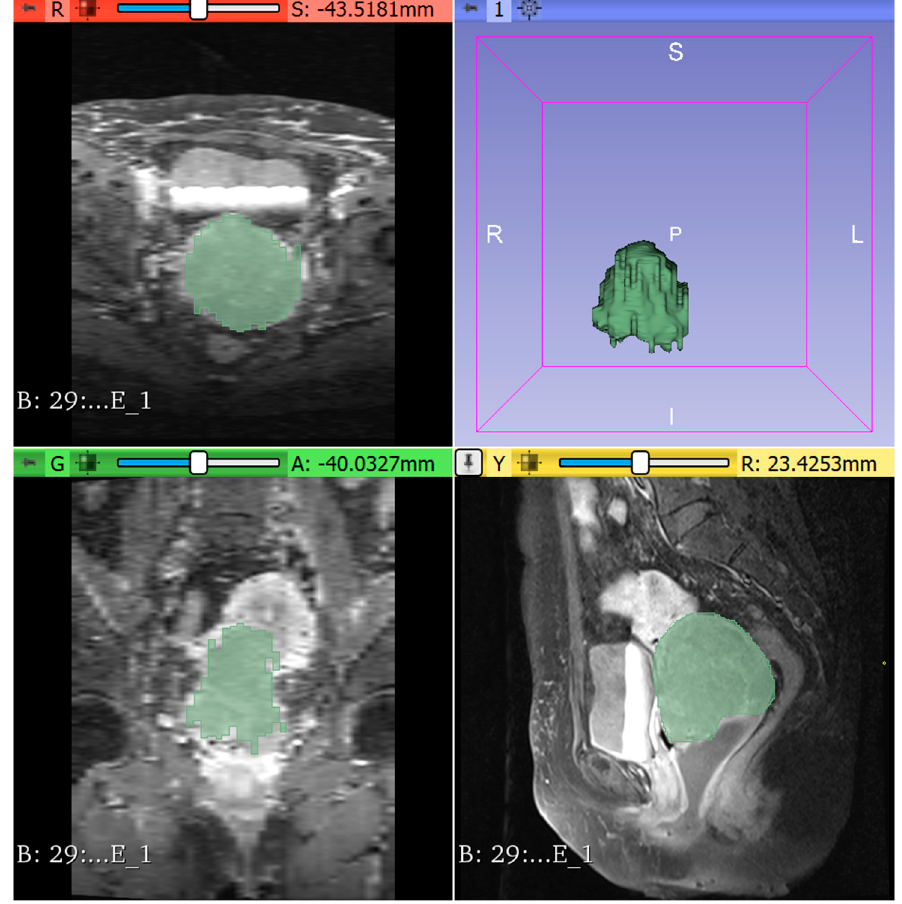
Figure 3. Example of flood-fill algorithm segmentation using 3D slicer software.